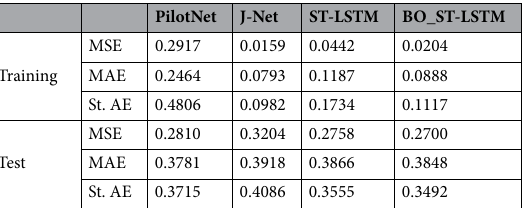
Table 5. Average values of the prediction performance indicators on the training and test